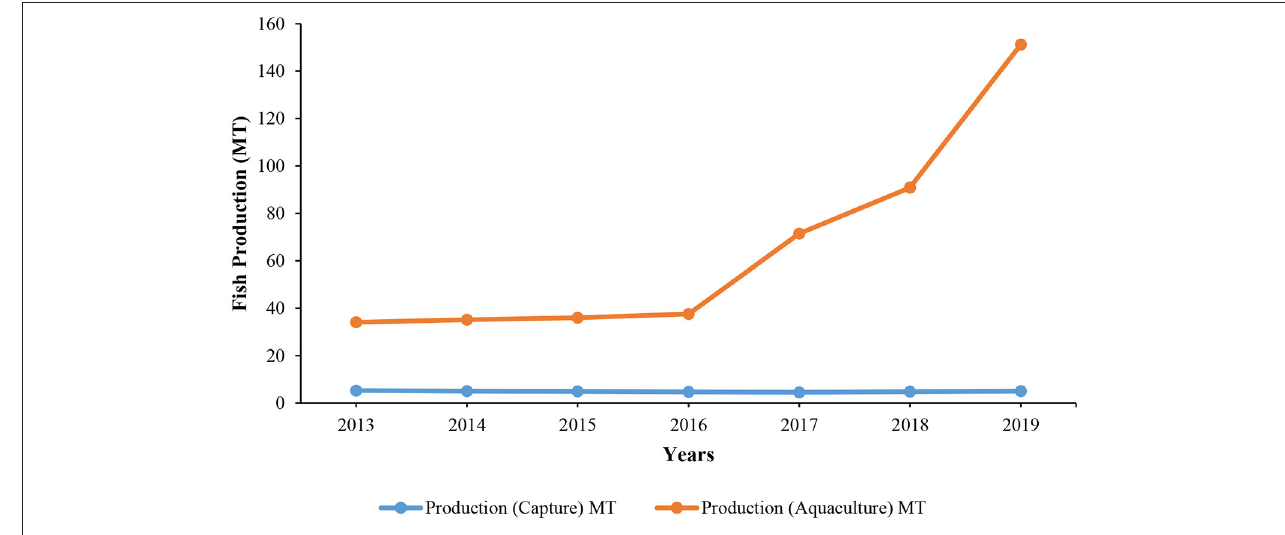
FIGURE 4 | Aquaculture and capture fisheries production trends in Busia